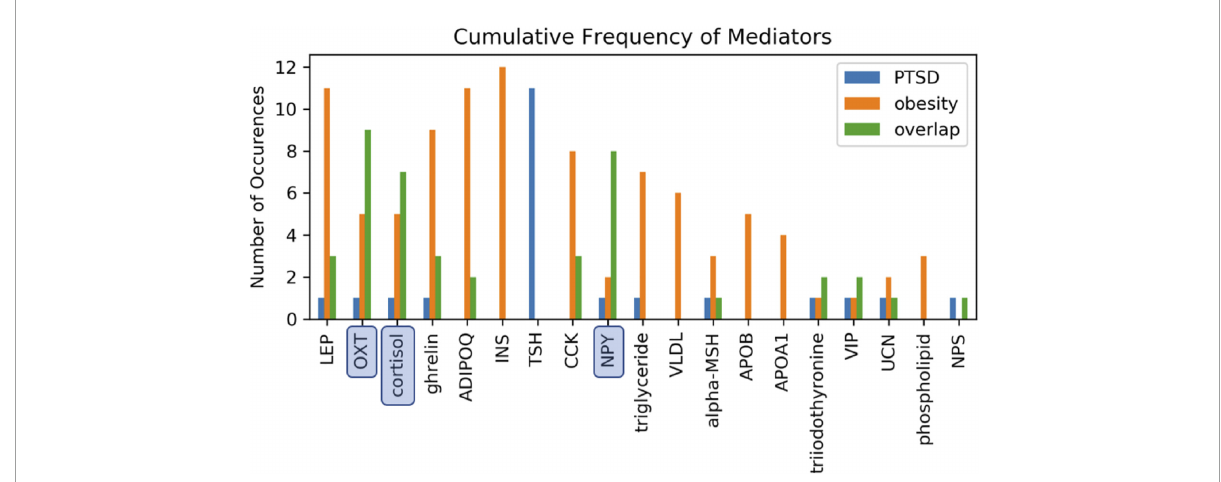
FIGURE4 Involvement of cascading regulators. Mediation of one or both health conditions involving two-intermediate metabolic regulators reported as the number of available path occurences. Paths annotated as overlapping involve the same two intermediate mediators to simultaneously link stress to both PTSD and obesity. Oxytocin (OXT), neuropeptide Y (NPY), and cortisol were most frequently involved in jointly mediating PTSD and